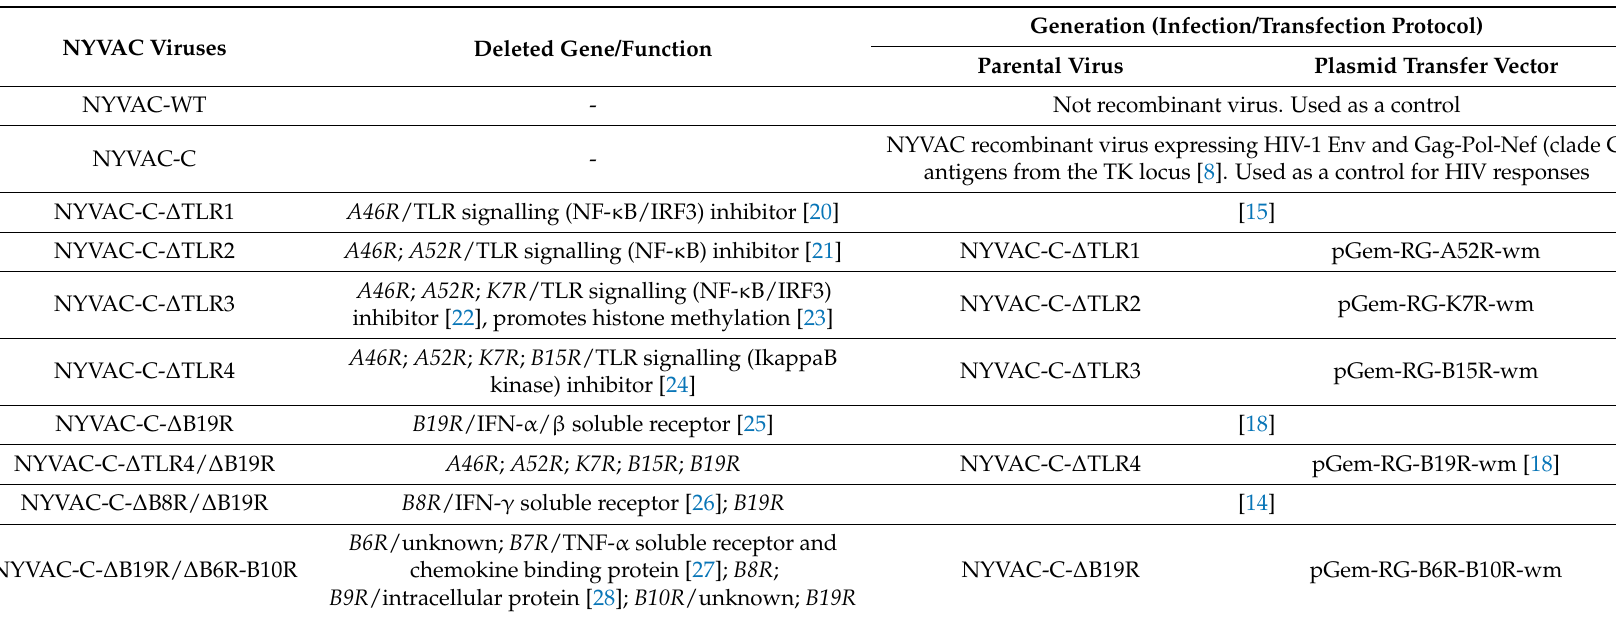
Table 1. New York vaccinia virus (NYVAC) deletion mutants used in this study. The genes are named according to Copenhagen strain